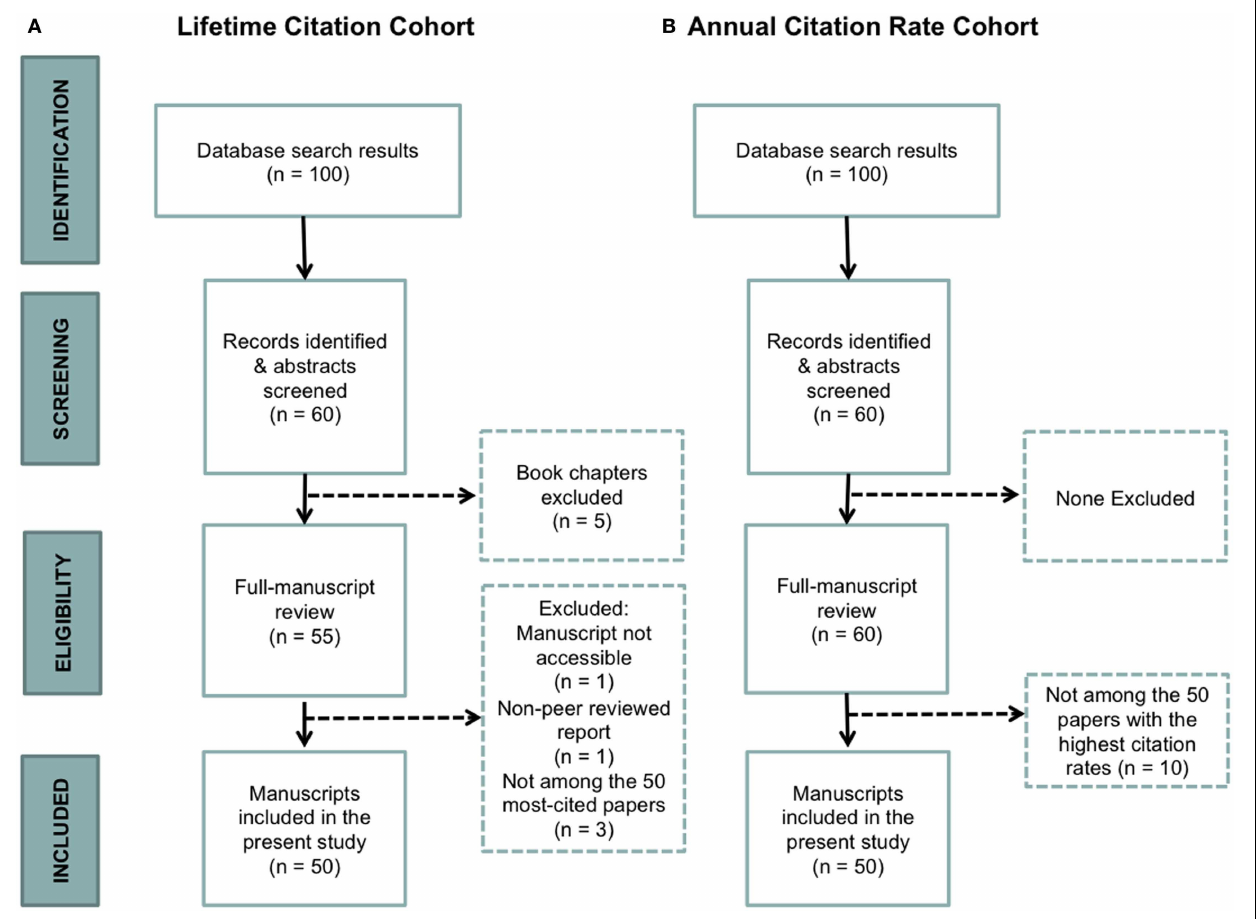
FIGURE 1 | Flow diagram representing the study selection process . (A) Lifetime citation cohort. (B) Annual citation rate